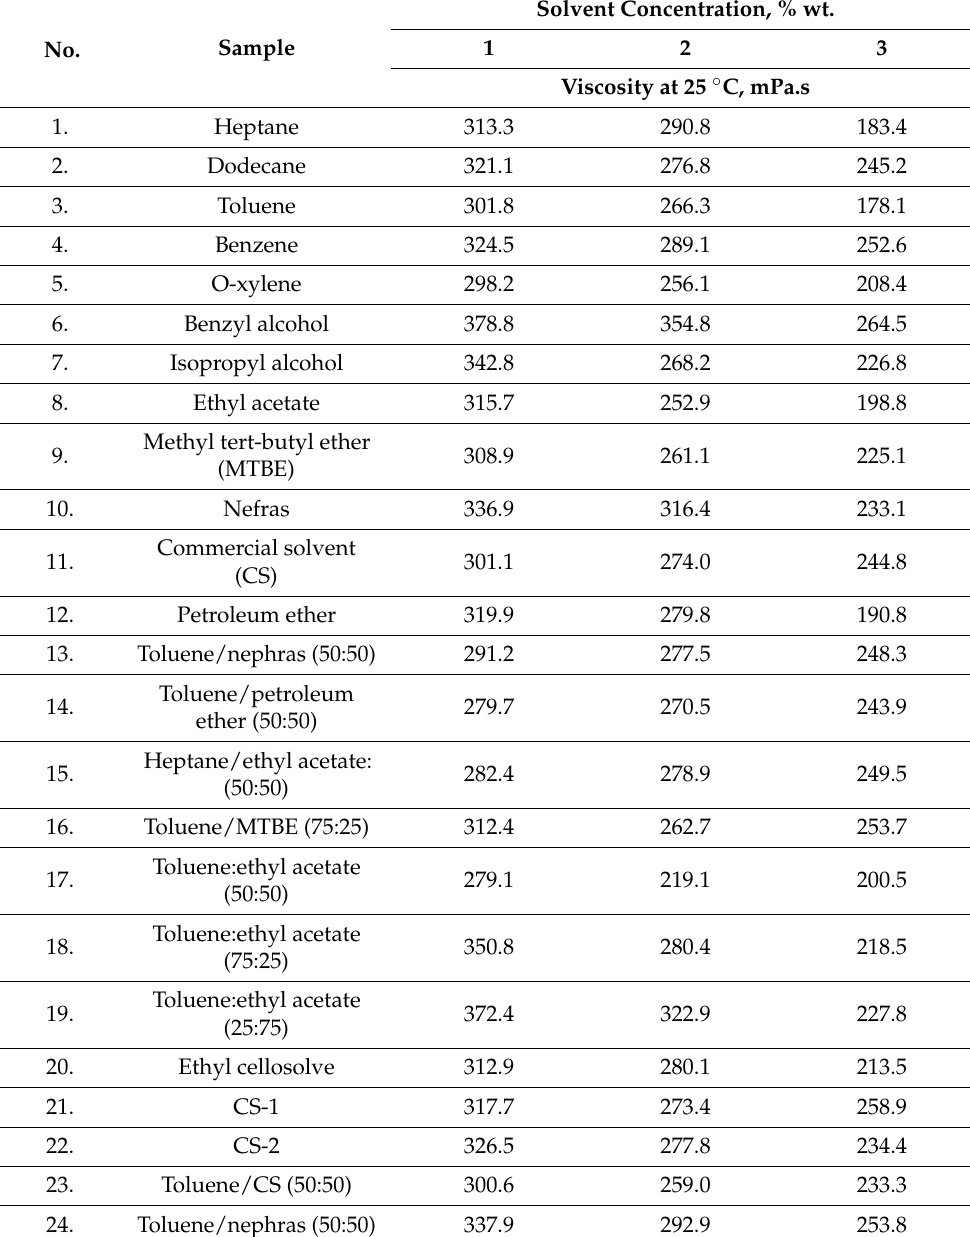
Table 4. Changes in the oil viscosity dynamics in the presence of different